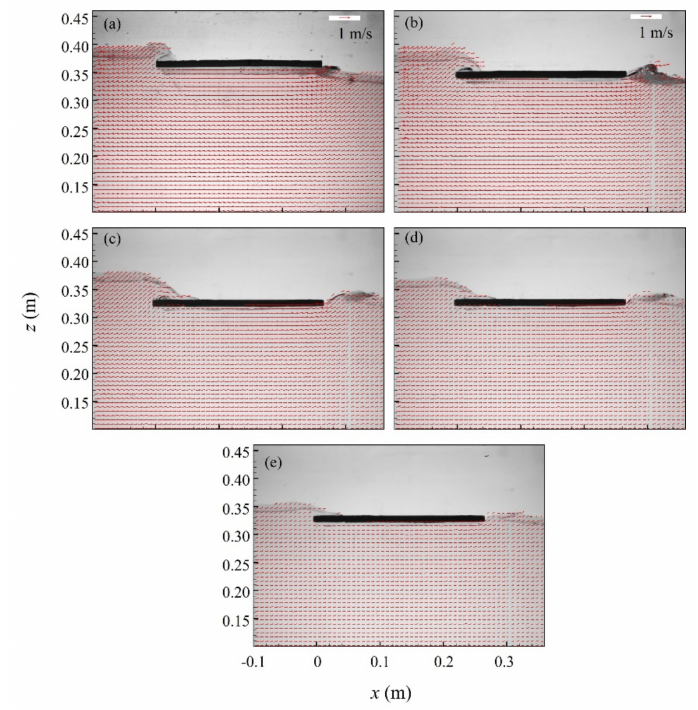
Figure 7. Measured velocity fields around the plate of different cases at T = 0.17 (Phase A): ( a ) case 1, D / h = 6/30, H / h = 10/30; ( b ) case 2, D / h = 4/30, H / h = 10/30; ( c ) case 3, D / h = 2/30, H / h = 10/30; ( d ) case 4, D / h = 2/30, H / h = 8/30; and ( e ) case 5, D / h = 2/30, H / h = 6/30.